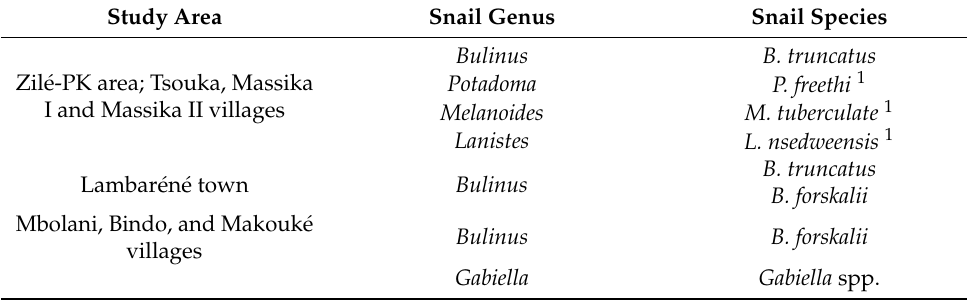
Table 1. Distribution of snail species collected by study area.